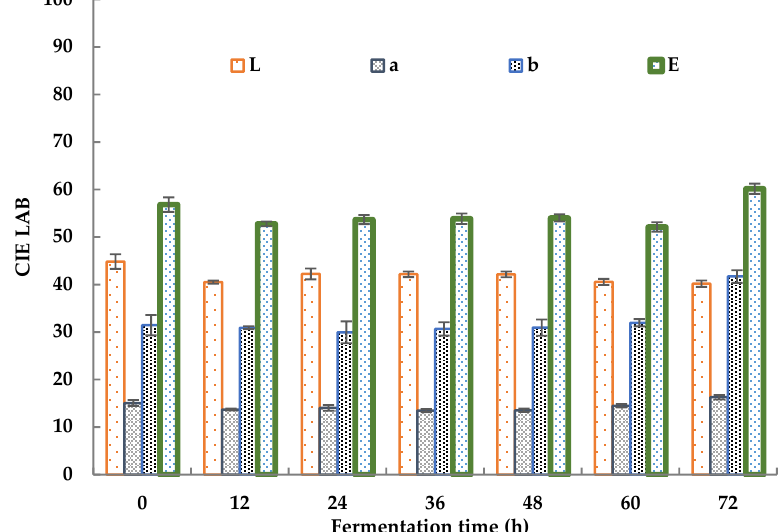
Figure 2. Color changes in sea buckthorn juice during fermentation. The total color chromaticity (E) decreased from 56.82 ± 2.33 to 52.78 ± 0.49 in the first 12 h of fermentation. It slightly increased to 53.85 ± 0.95 after 24 h of fermentation and then held a steady value from 24 h to 48 h, decreased to 52.13 ± 0.98 after 60 h, and increased to 60.16 ± 1.16 after 72 h. The decrease in E during the initial 12 h was mainly caused by a decrease in the red value (a) and light value (L). The red value showed a decrease from 15.07 ± 0.63 to 13.70 ± 0.19, and the light value decreased from 44.84 ± 1.53 to 40.52 ± 0.32. The proliferation of microorganisms led to an increase in the turbidity of the sea buckthorn juice, which led to a decrease in the L value. The consumption of nutrients by microorganisms led to a decrease in the turbidity of the sea buckthorn juice, which led to an increase in the L value [49]. The changes in the a and b values were due to changes in some colored compounds, including polyphenols, flavonoids, carotene, and so on [47]. The increase in E after 72 h was mainly caused by an increase in the blue value (b), which increased from 31.96 ± 0.77 to 41.69 ± 1.33. He et al. revealed the chromogenic mechanism of sea buckthorn. Its fruit color depended mainly on the ratio of lycopene to β -carotene, and the content of carotene was more than eight times that of lycopene